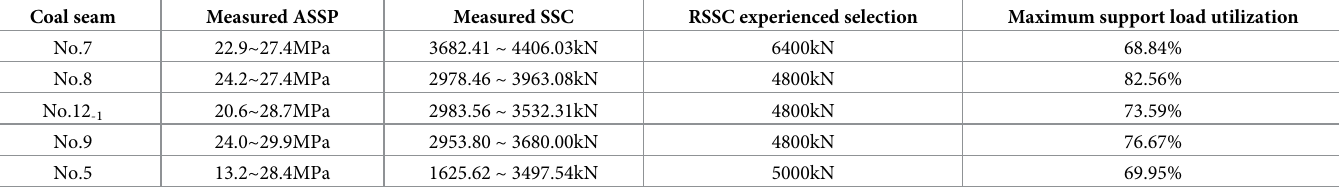
Table 17. SSC results of field measurement in each coal seam.